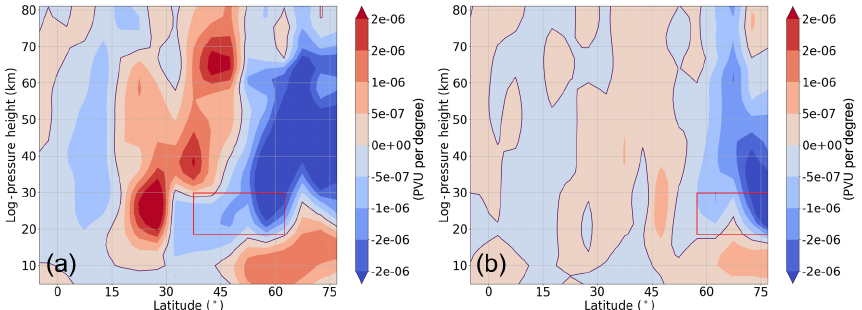
Figure 11. Meridional potential vorticity gradient difference between the respective H3 (a) and H7 (b) simulations and the reference simula- tion, representing the last 30d of the simulations. The positions of the H3 and H7 GW hotspots are represented by red boxes.